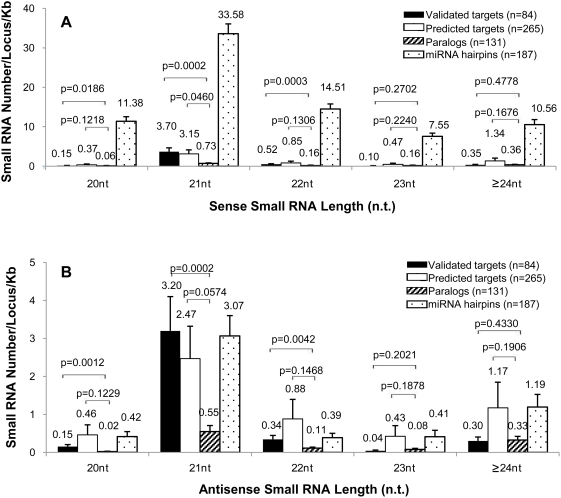
Normalized abundance of unique smRNAs from multiple deep sequencing datasets with perfect matches to miRNA-associated gene sets.(A) Number of unique smRNAs mapping to the sense strand of validated or predicted miRNA target genes, paralogous non-targets and MIRNA hairpins. (B) Number of unique smRNAs mapping to the antisense strand of validated and predicted miRNA targets, paralogous non-targets and MIRNA hairpins. smRNA sequences were obtained from published data [20],[28],[37],[38] and miRNA hairpin sequences were queried from the miRBase database (http://microrna.sanger.ac.uk/) [76]. The number of unique smRNAs were found by BLAST against the cDNA sequences or miRNA hairpins and then normalized by the length of each individual matching gene (see “Material and Methods” for details). The average number for each set of genes is presented here. Standard error bars are indicated in the plot. P values of Student's t-test (one-sided, equal variance assumed) are shown above the brackets between different groups.